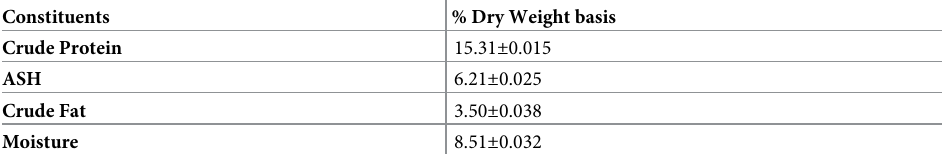
Table 1. Proximate analysis of quinoa.